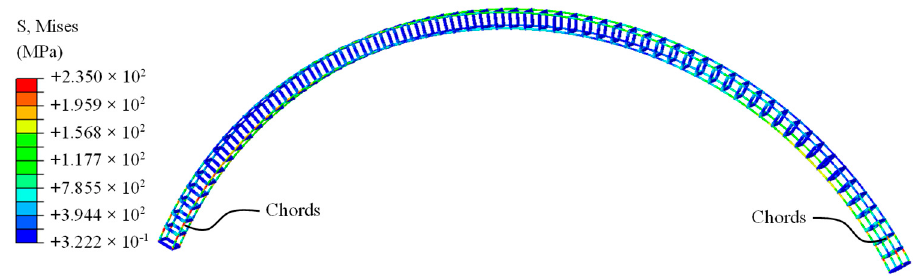
Figure 16. Stress distribution of the typical Vierendeel truss arch under the ultimate FSUVL.